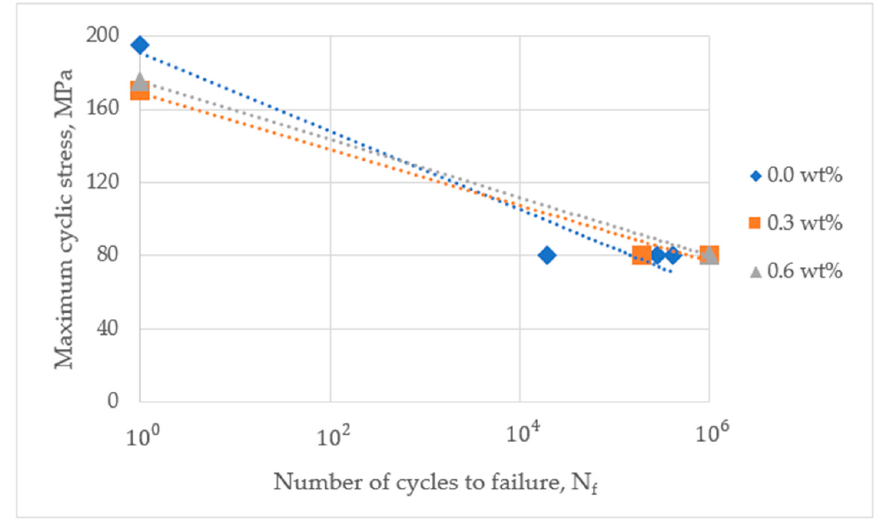
Figure 17. The number of cycles to failure of composite reinforced by 1 mm carbon fiber length under cyclic loading.